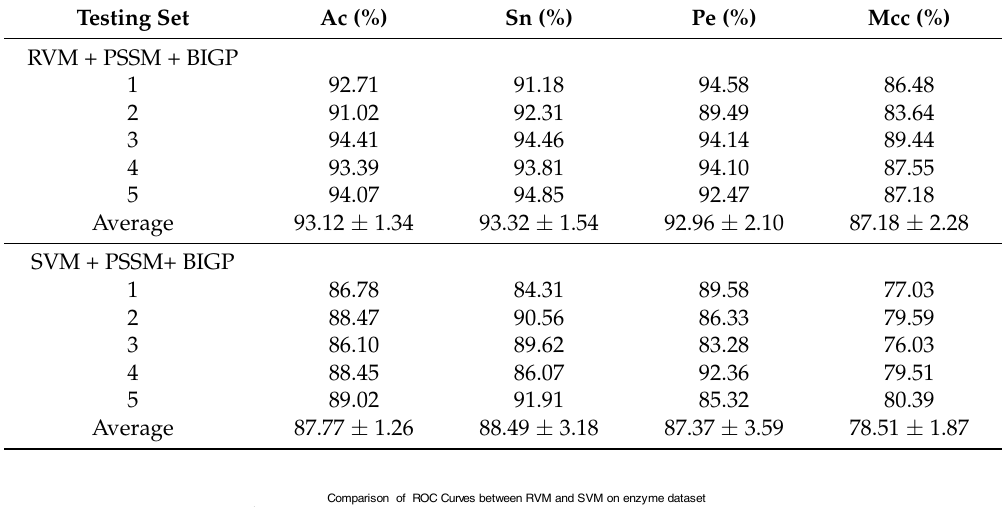
Table 6. 5-fold cross validation results performed by SVM and RVM classifier on an ion channel dataset. Comparison of ROC Curves between RVM and SVM on enzyme dataset